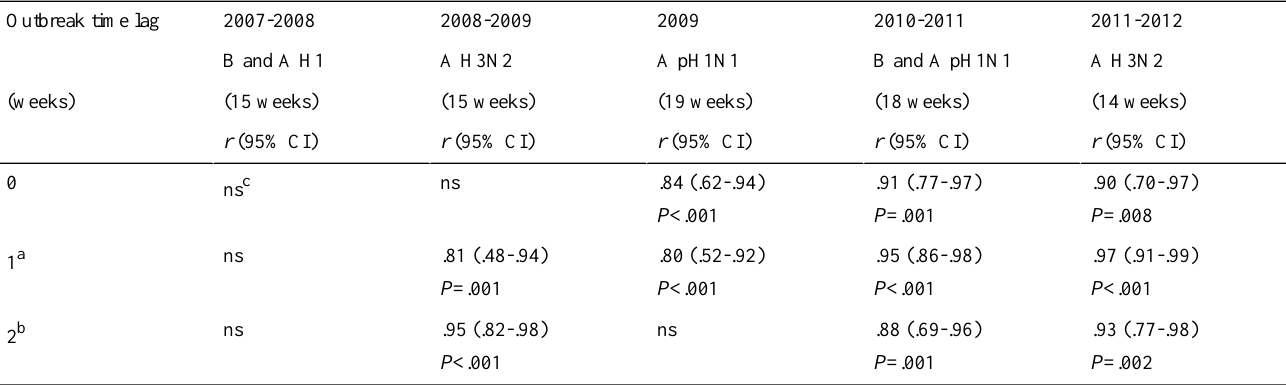
Table 3. Associations on a weekly basis between telenursing call data and influenza case data displayed by the correlation coefficient r (95% CI), for the five influenza outbreaks observed in Östergötland county, Sweden, during the study period